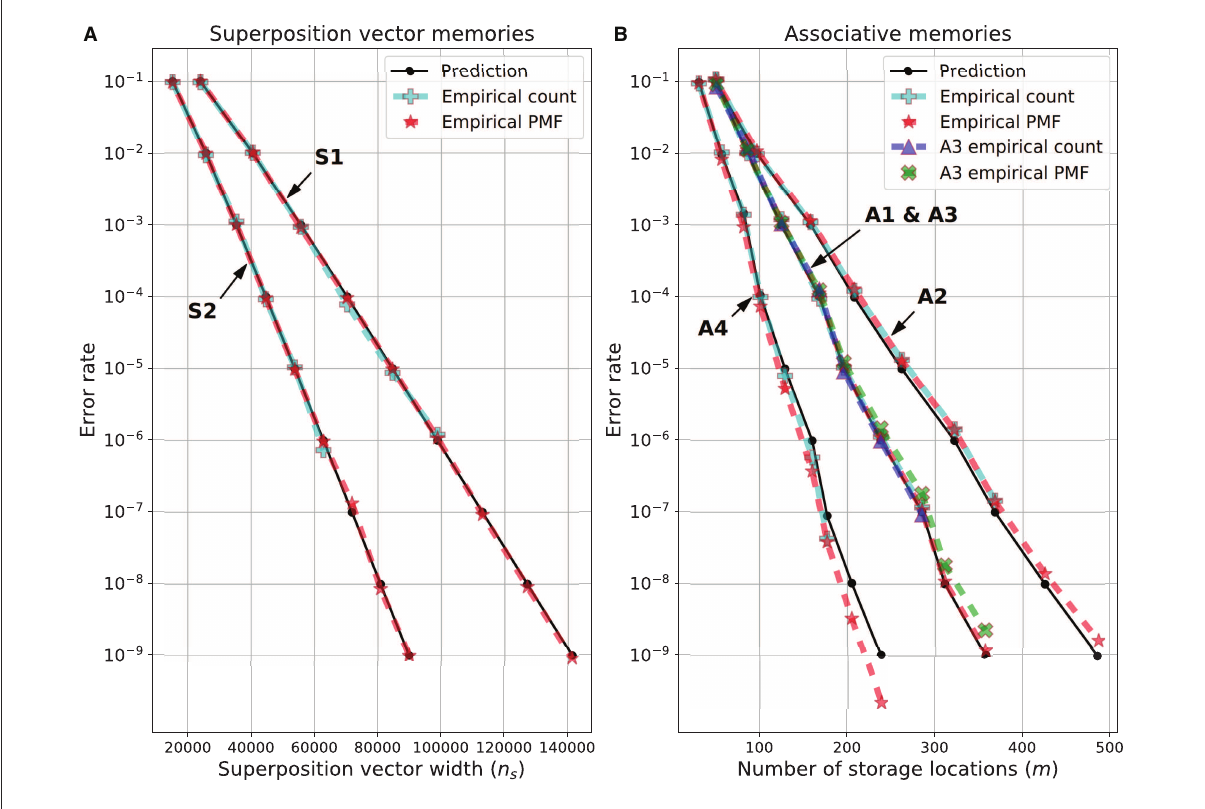
FIGURE3 Predicted and empirical error rate vs. dimensions for memory variations. (A) Superposition vectors ( S1 and S2 ). (B) SDM variations A1 - A4 . The dimensions of each memory variation for each error rate are given in Table